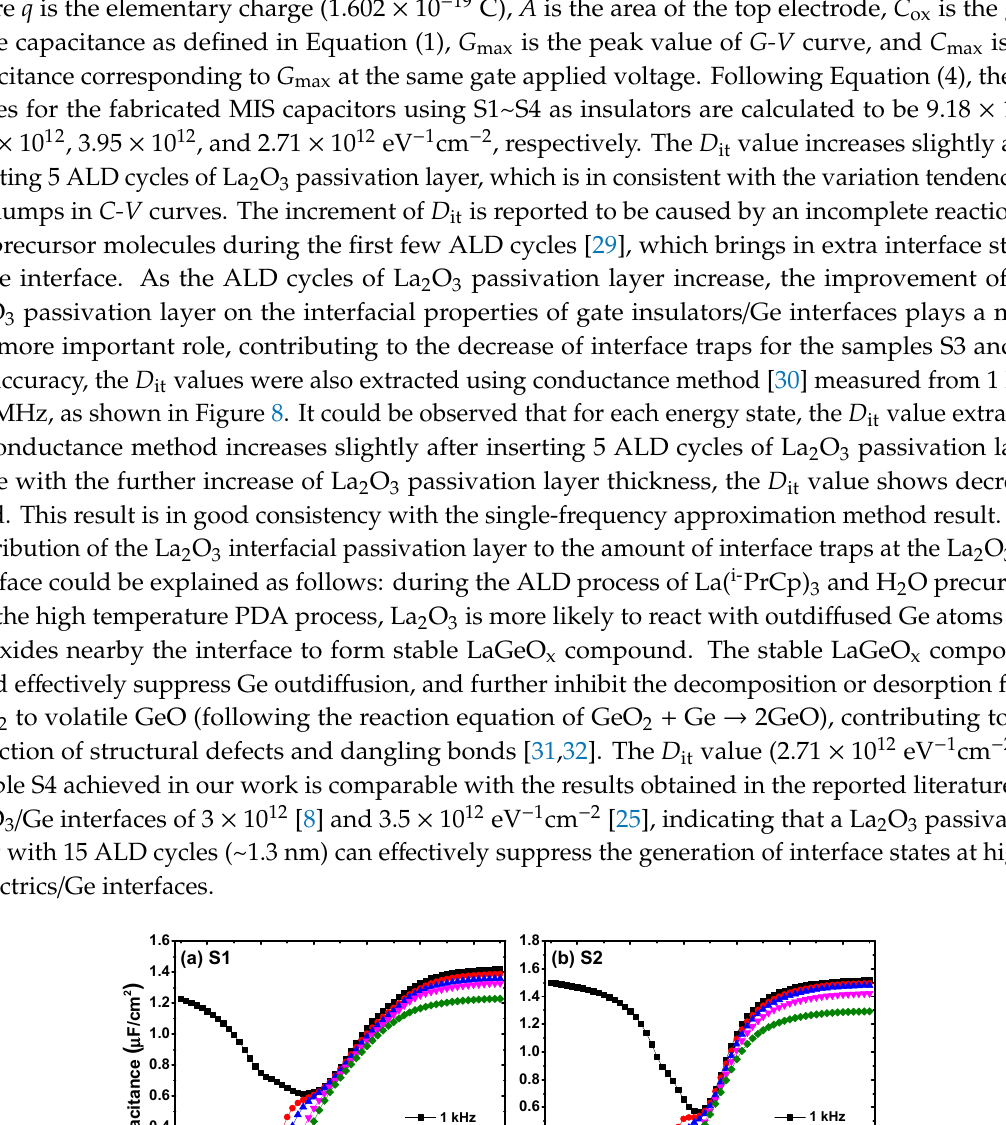
Figure 8. Energy distribution of the interface states at the interface between the deposited films and Ge substrates. It is also observed from the C-V curves that the flat band voltages ( V FB ) translate toward positive voltages with the increase of La 2 O 3 passivation layer deposition cycles. To further investigate this phenomenon in detail, the V FB values of the capacitors were extracted using the Hauser NCSU CVC simulation software taking into account of quantum-mechanical effects [33]. Considering the work function difference between the top electrode aluminum and the n-type Ge substrate with a doping concentration of 1 × 10 16 cm − 3 , the ideal V FB should be 0.03 V. However, the actual V FB swept forward for the control sample is − 0.206 V. The negative V FB shift indicates the existence of effective positive oxide charges in the HfO 2 film. The effective positive oxide charges 0.00